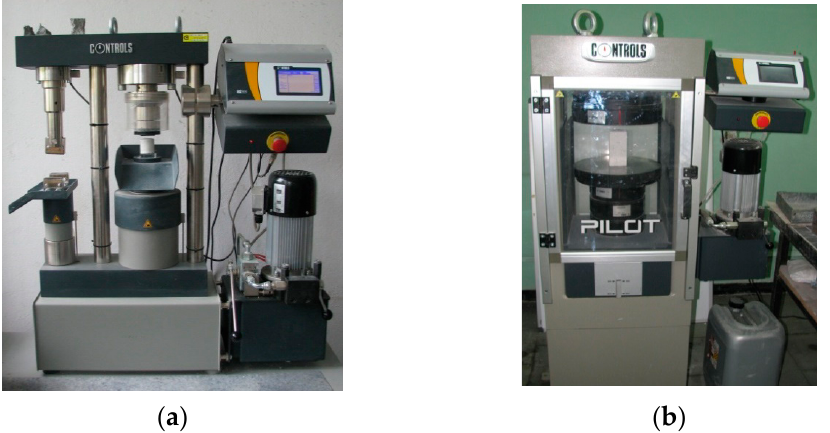
Figure 2. Testing compressive strength of AAC specimens [27]: ( a ) tests on cores using a strength testing machine with an operating range of 100 kN, and ( b ) tests on cuboid specimens using a strength testing machine with an operating range of 3000 kN.